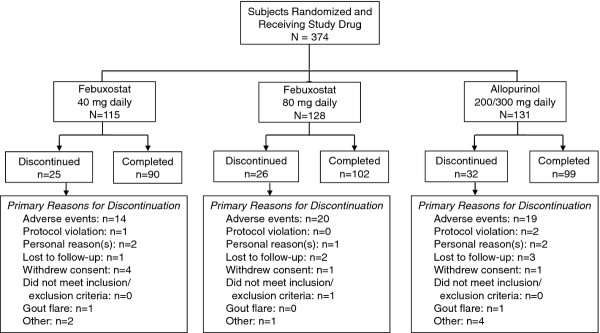
Flow of Subjects Through the Study.